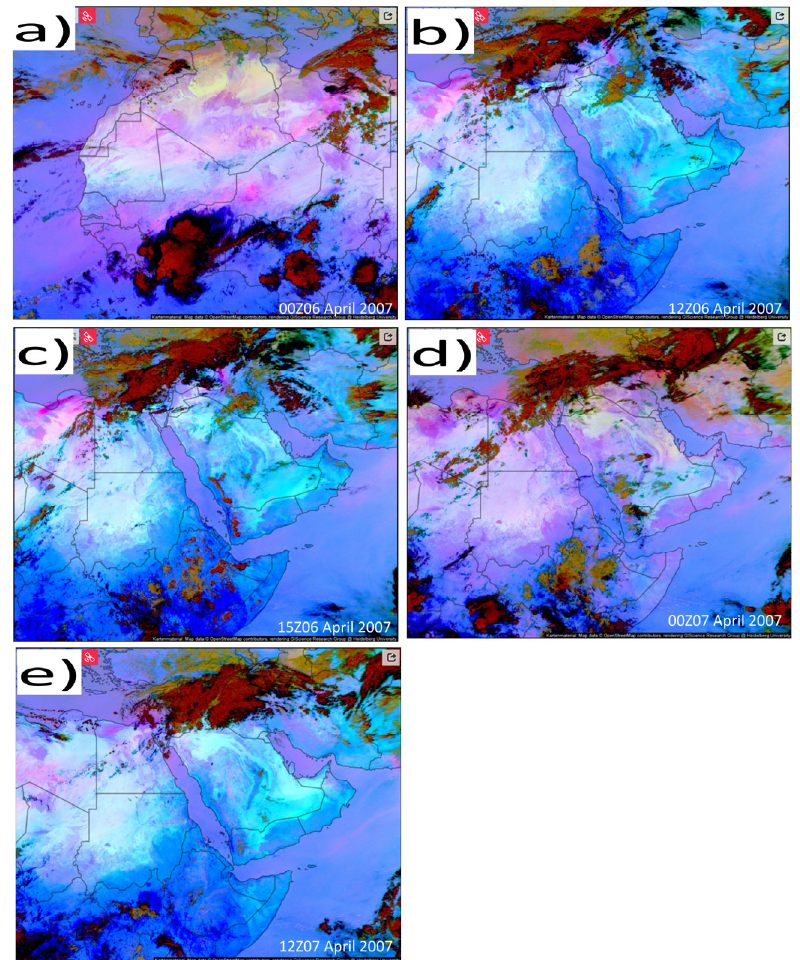
Figure 5. MSG SEVIRI ‐ derived false color images over North Africa showing dust (pink/purple), clouds (brown/orange), and differences in surface emissivity retrieved in absence of dust or clouds (light blue/blue) on ( a ) 00Z06 April 2007, ( b ) 12Z06 April 2007, ( c ) 15Z06 April 2007, ( d ) 00Z07 April 2007, and ( e ) 12Z07 April 2007. (https://meteologix.com/eg/satellite/africa-northeast/satellite- dust-15min/20070406-1000z.html; accessed on 14 November